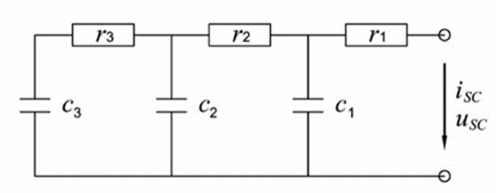
Figure 6. Equivalent circuit for a